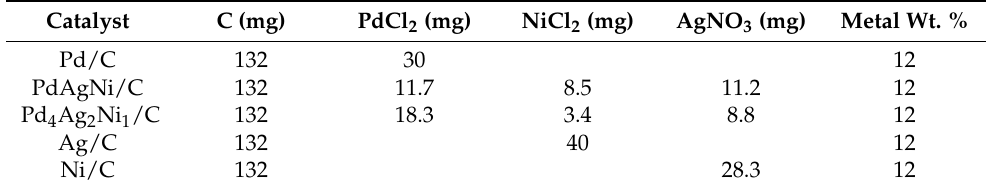
Table 1. Stochiometric added quantities of C, PdCl 2 , AgNO 3 , NiCl 2 to synthesize Pd/C. PdAgNi/C, and Pd 4 Ag 2 Ni 1